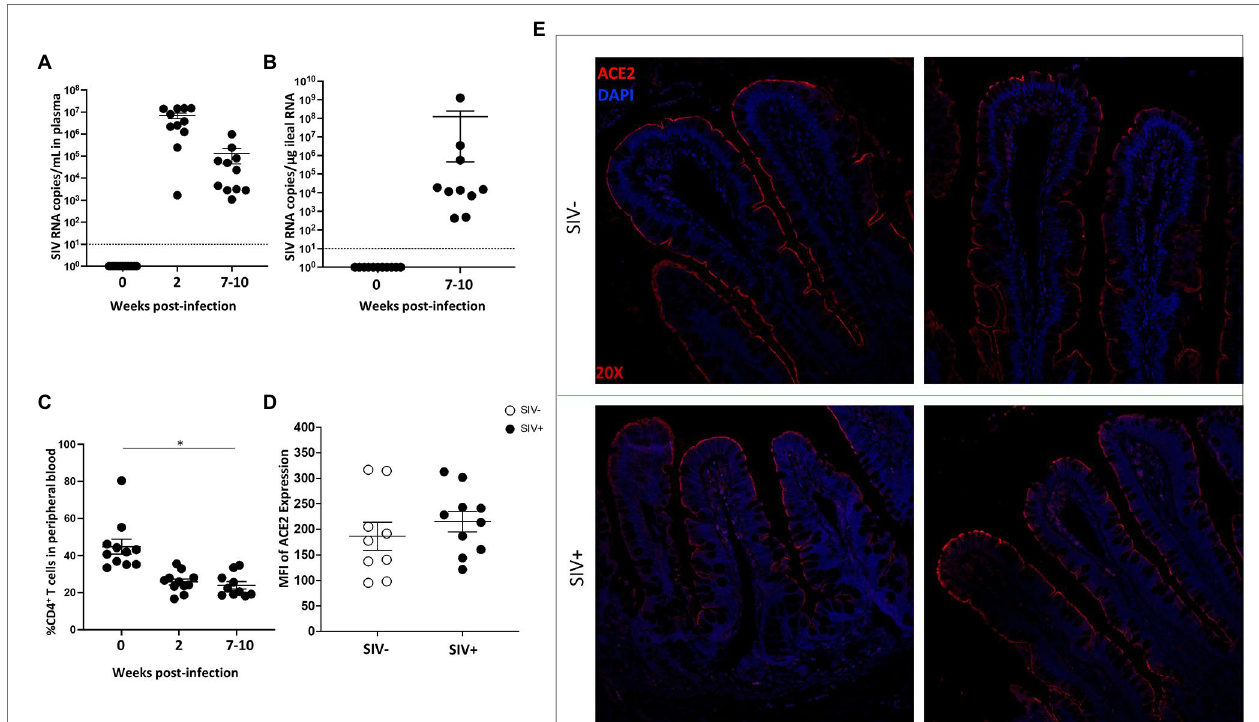
FIGURE 1 | ACE2 expression is abundant in the gut epithelium of rhesus macaque in SIV infection. (A) and (B) Viral RNA copies were measured in plasma samples and in ileum tissue from SIV infected rhesus macaques (SIV+, n = 10). (C) Longitudinal CD4+ T cell depletion in peripheral blood of SIV infected animals was